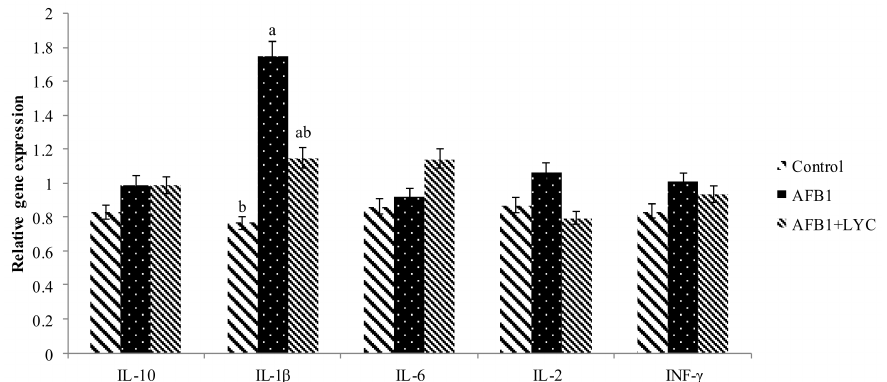
Figure 1. Effects of LYC on inflammatory gene expression level in the jejunum of broiler intestine fed AFB 1 contaminated diets at 21 and 42 d. The column and its bar represented the means and standard error of the means ( n = 6), respectively. a, b Means with different superscript letters are significantly different ( p < 0.05). IL-10, interleukin-10; IL-1 β , interleukin-1beta; IL-6, interleukin- 6; IL-2, interleukin-2; INF- γ , interferon- γ ; AFB 1 , AflatoxinB 1 ; LYC, Lycopene; and AFB 1 + LYC, (100 µ g/kg AFB 1 + 200 mg/kg